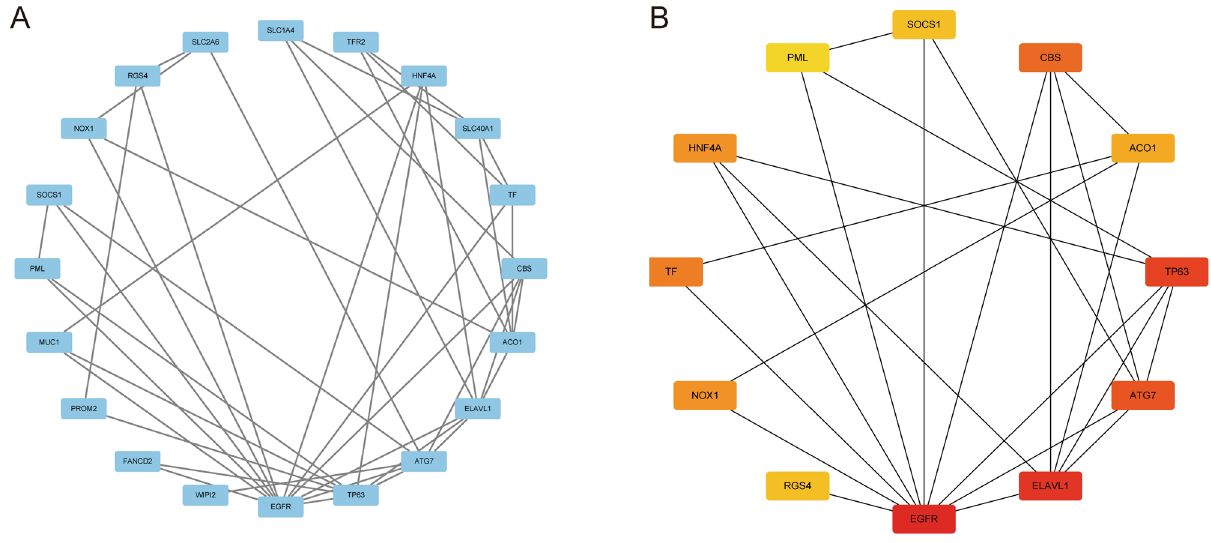
Figure 4. PPI networks of ferroptosis-related DEGs. ( A ) The initial PPI network covering 20 nodes and 43 edges using Cytoscape. ( B ) The PPI network covering 12 nodes and 24 edges after filtering by cytoHubba.